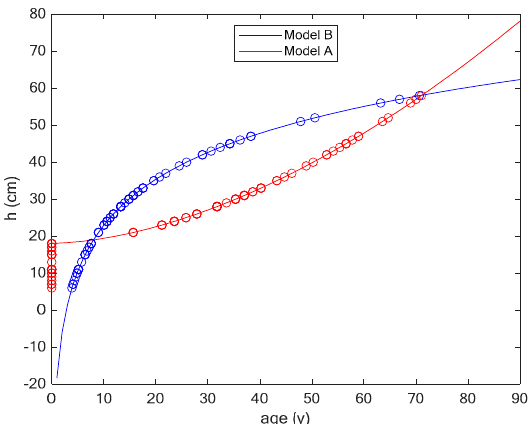
Figure 7. Age of the Eunicella verrucosa colonies off Sanremo, obtained from the height measure, using the two considered models.